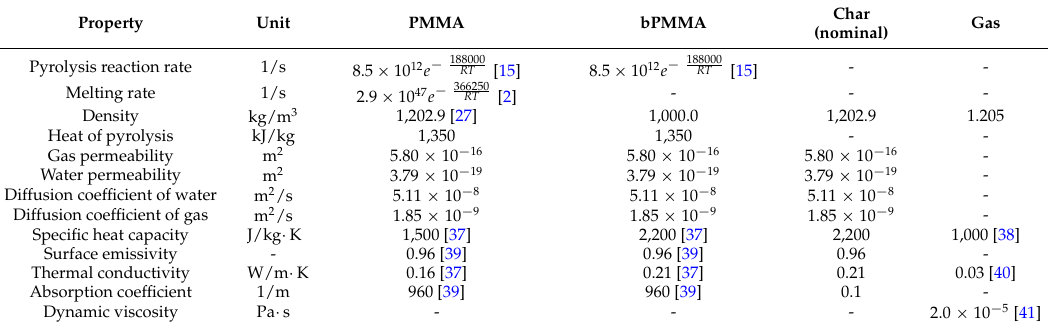
Table 2. The thermal properties of PMMA taken as the input for